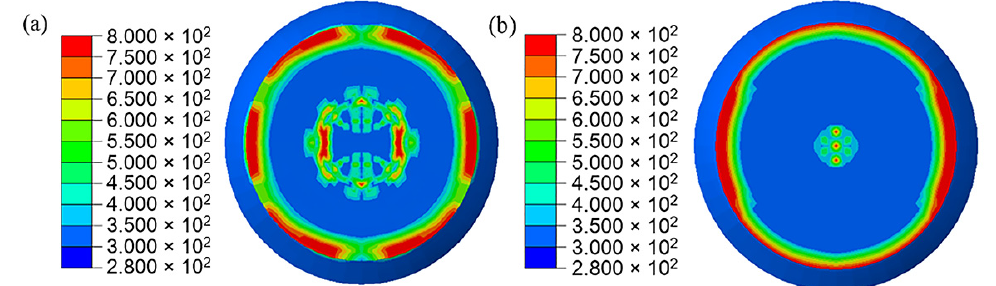
Figure 22. Initiation zone in PBX1314. ( a ) No friction between the projectile and PBX1314 (It corresponds to the Figure 16d in the manuscript), ( b ) Friction exists between the projectile and PBX1314.